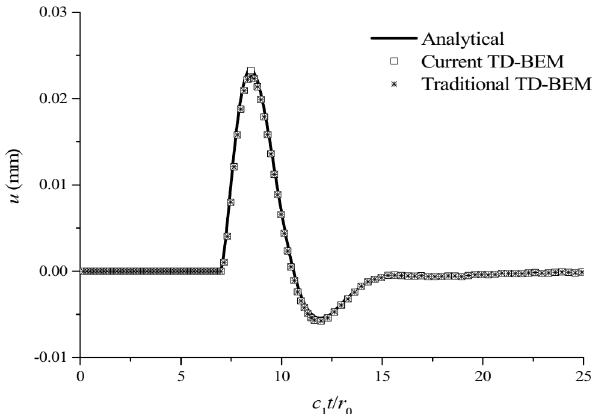
Figure 14. Calculated radial displacements at r = 8 m from the proposed 3D TD-BEM, the traditional 3D TD-BEM and the analytical